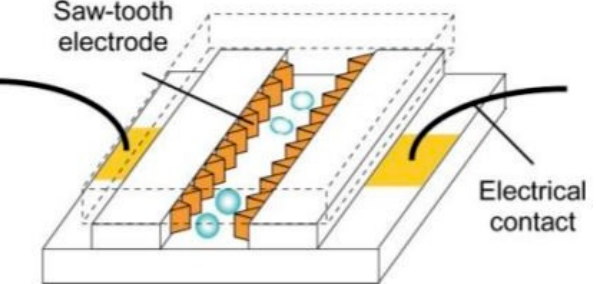
Figure 21. Schematics of a micro electroporation device with only one set of electrodes for cell lysis utilized in [76]. Adapted with permission from [76]. Copyright 2006 Royal Society of Chemistry.